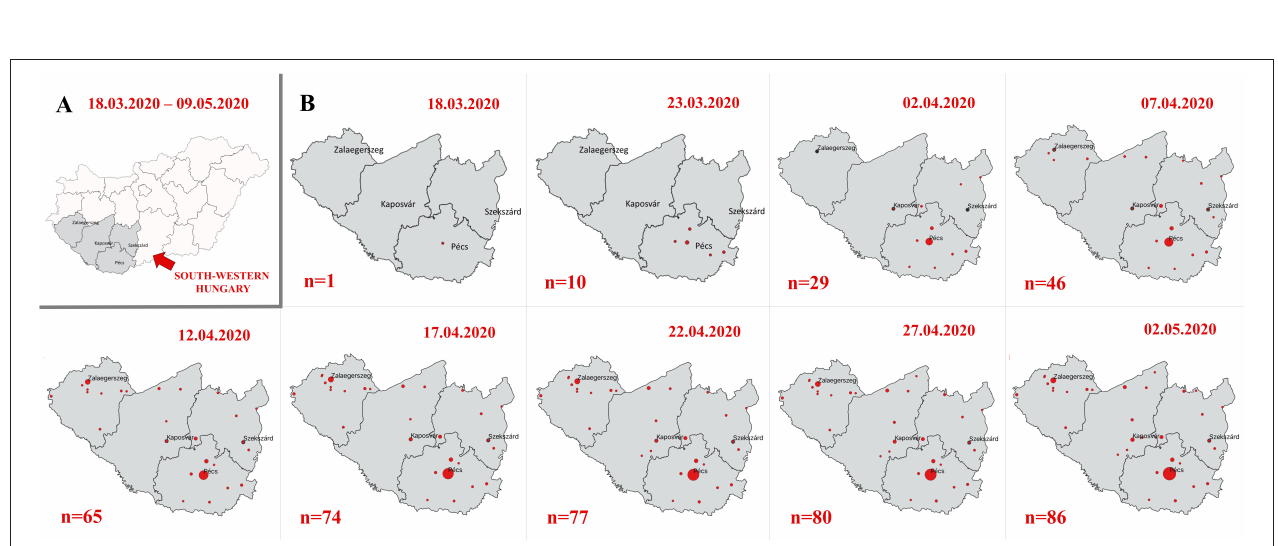
FIGURE 2 | Incident cases representing the dynamics of the pandemic spreading in 5-day intervals. (A) Hungary and (B) south-western Hungary.